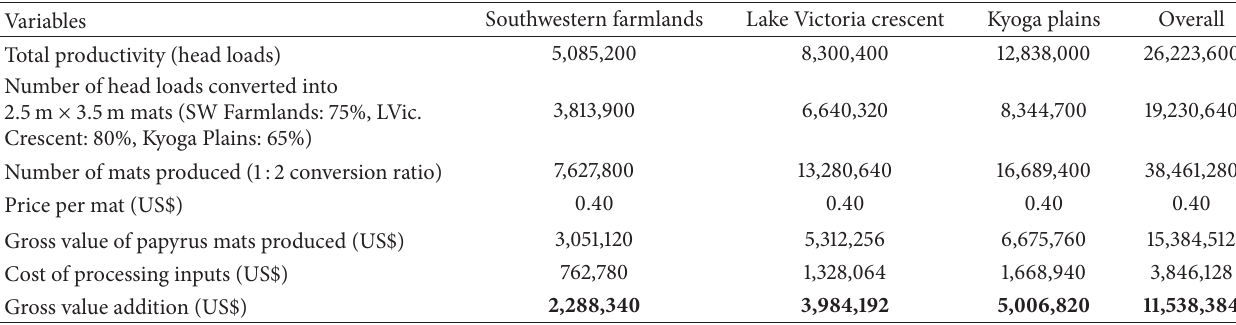
Table 11: The economic value of papyrus after value addition through mat making.